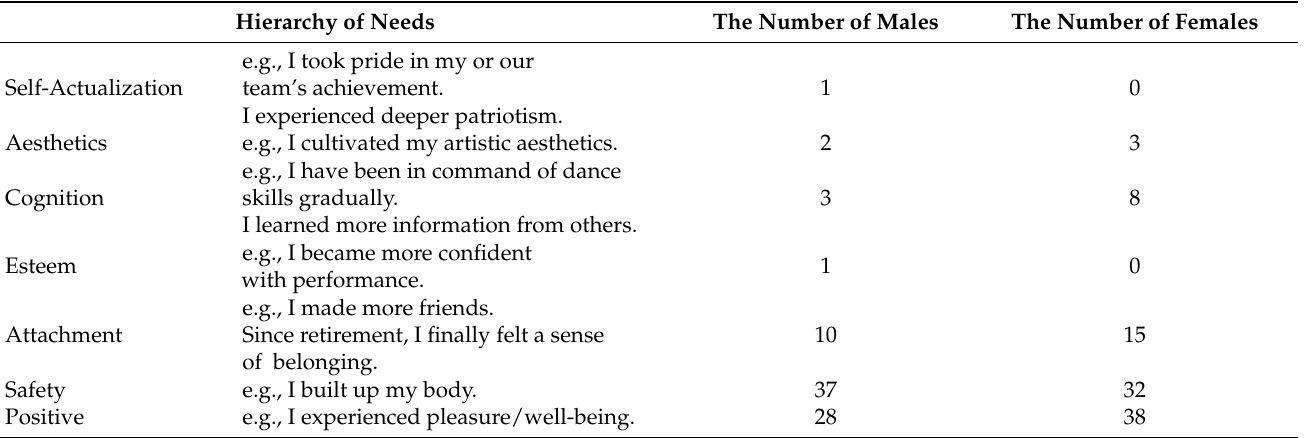
Table 3. The answers of question 22 to measure the motivation of participating in square dance (N = 63 +